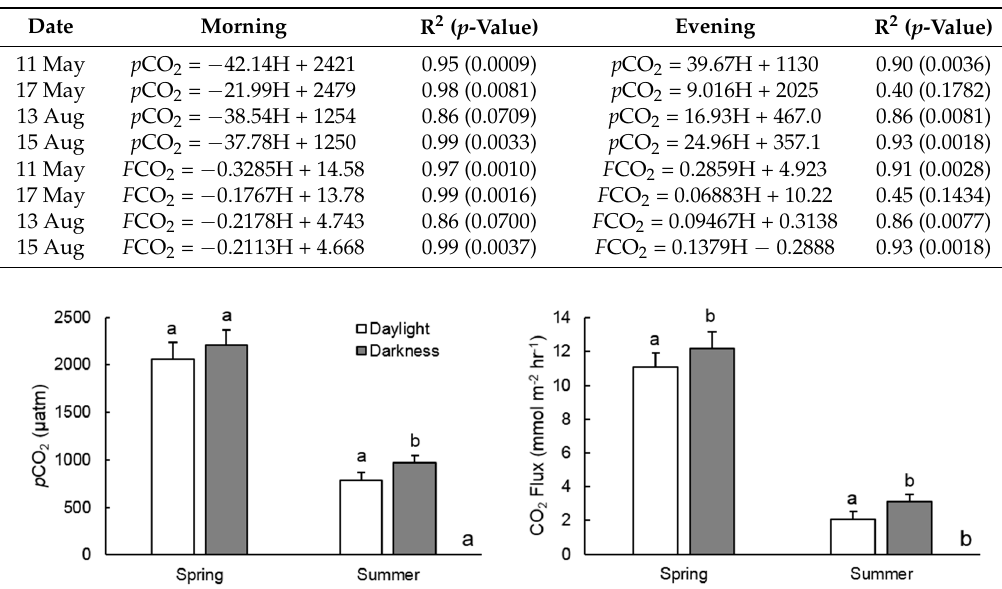
Figure 4. Mean p CO 2 ( a ) and CO 2 ( b ) outgassing rates during darkness and daylight hours by season. Bar pairs with different letters above them represent a significant difference between populations at α = 0.05. Error bars represent standard